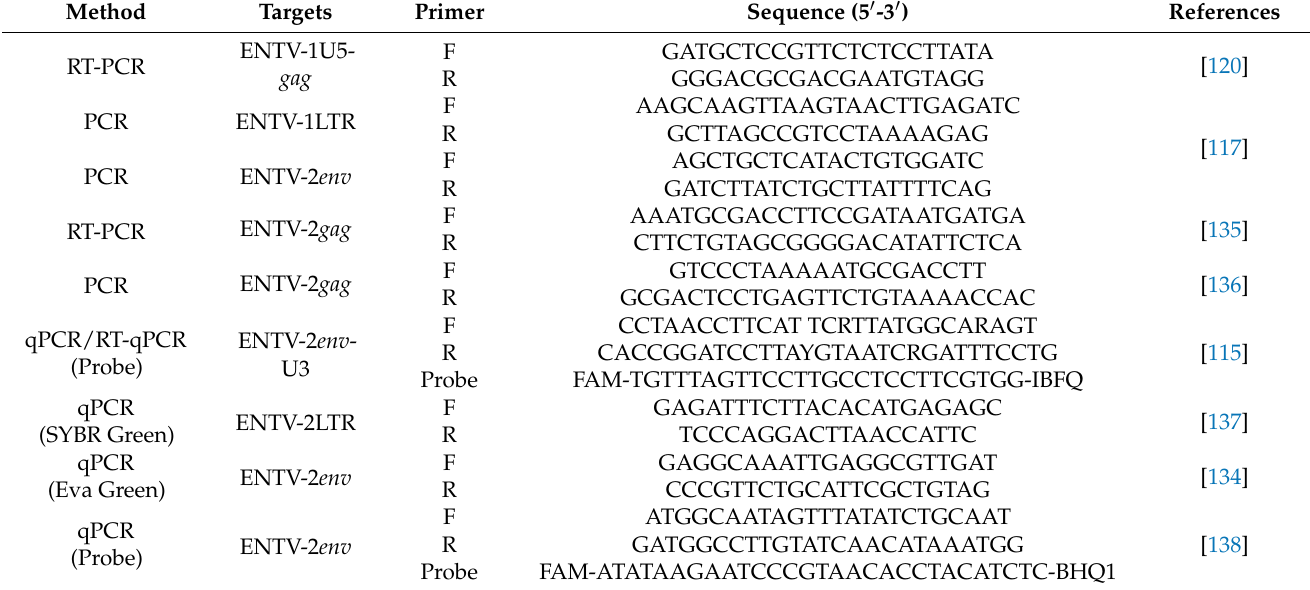
Table 5. PCR methods developed for ENTV